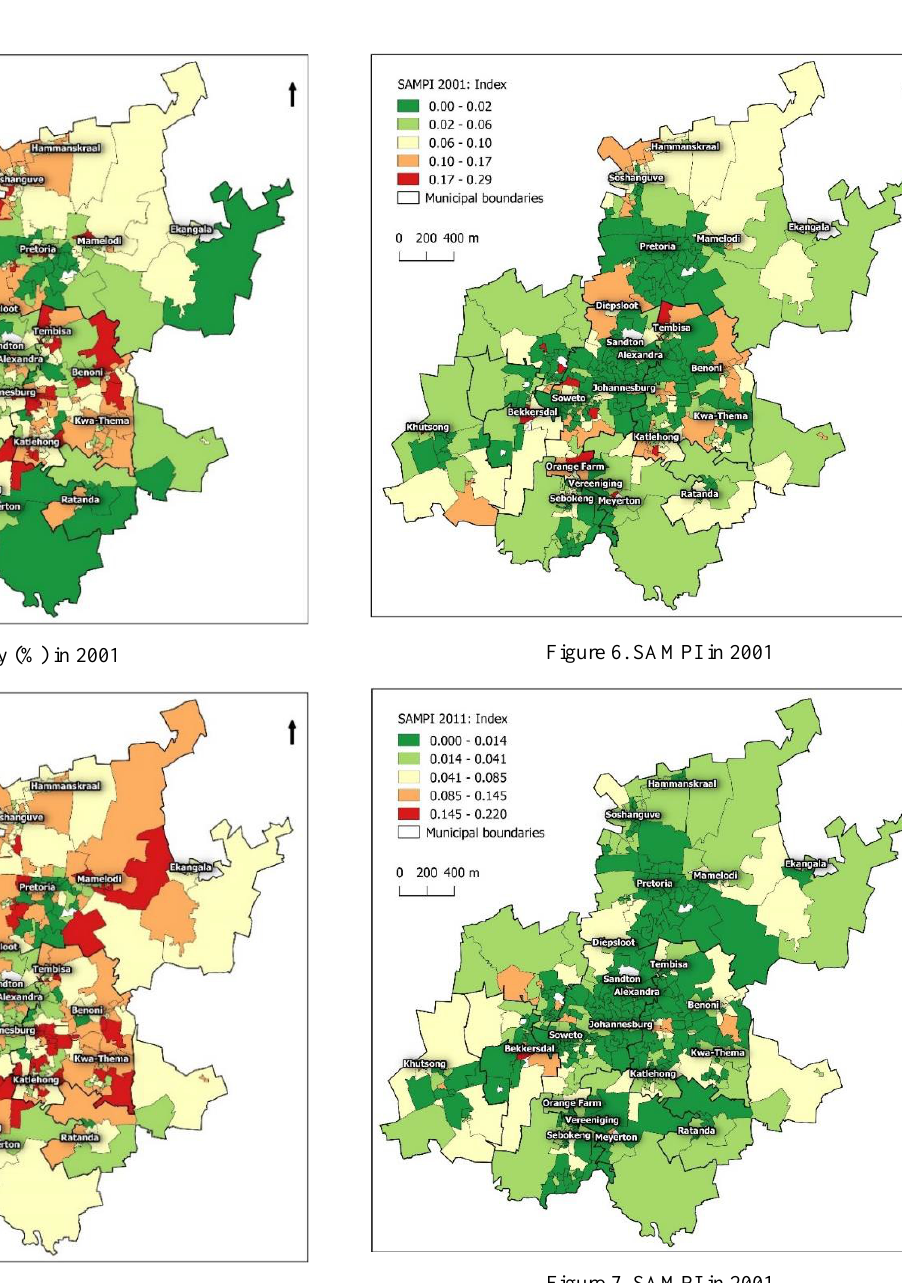
Figure 5. Intensity of poverty (%) in 2011 Figure 6 and Figure 7 illustrate the mapping of SAMPI (product of headcount by the intensity of poverty) in 2001 and 2011. Overall, poverty was more prevalent in 2001 as compared to became less affected in 2011.